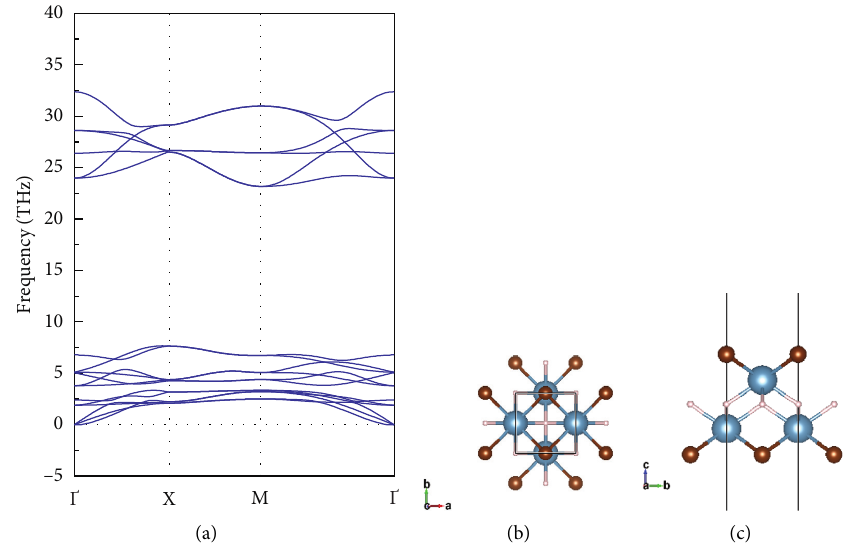
Figure 2: (a) The calculated phonon dispersion curves of monolayer CaHBr. (b) and (c) Main view and side view of primitive unit cell of monolayer CaHBr.